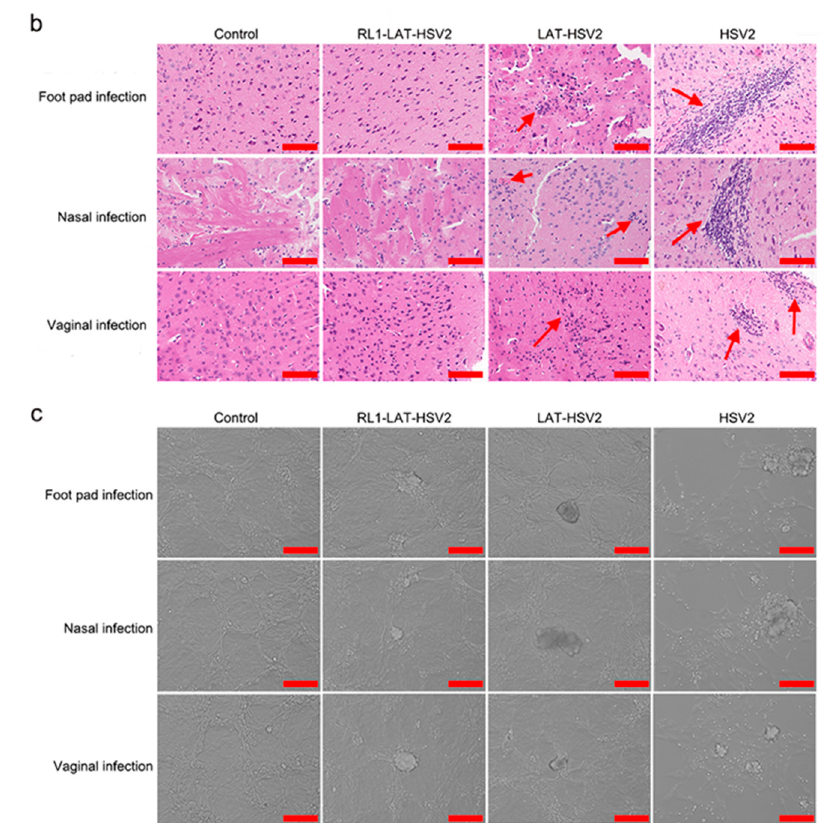
Figure 4. The latent infection capacity of RL1-LAT- HSV-2 is reduced in infected mice. ( a ) Viral loads were determined in various tissues, including the brain, spinal cord, trigeminal nerve, dorsal root ganglia and local tissues (footpad, nose and vagina), from RL1-LAT- HSV-2-, LAT- HSV-2 and HSV-2-infected mice subjected to footpad infection, nasal infection and vaginal infection. ( b ) Pathological changes in the brain tissue of mice infected with RL1-LAT- HSV-2, LAT- HSV-2 or HSV-2 via footpad challenge, nasal challenge and vaginal challenge. Red arrows indicate the infiltration of inflammatory cells. Samples were obtained at 2 months postinfection. Scale bar = 100 µ m. ( c ) Vero cells cocultured with dorsal ganglia of infected mice at 2 months post viral challenge. Scale bars = 100 µ m. The data are shown as the mean ± SD. Statistical significance was measured by the log-rank test. * p < 0.05, ** p < 0.01; *** p <